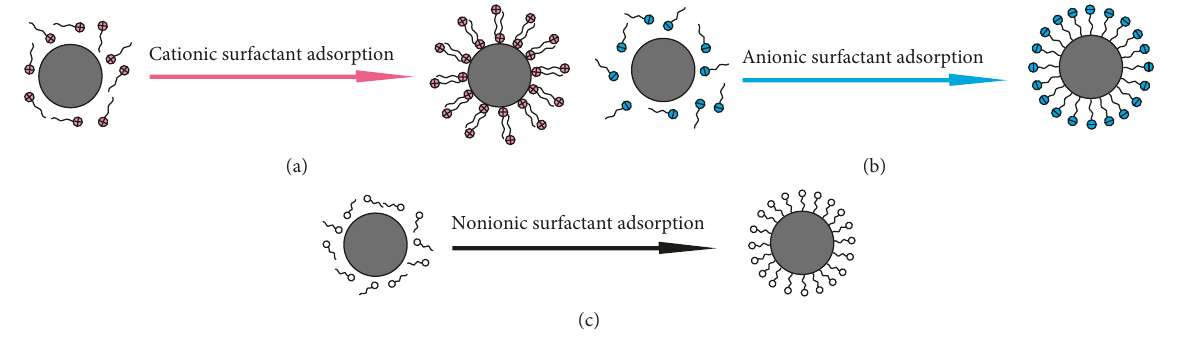
Figure 10: The adsorption process of coal dust by the different